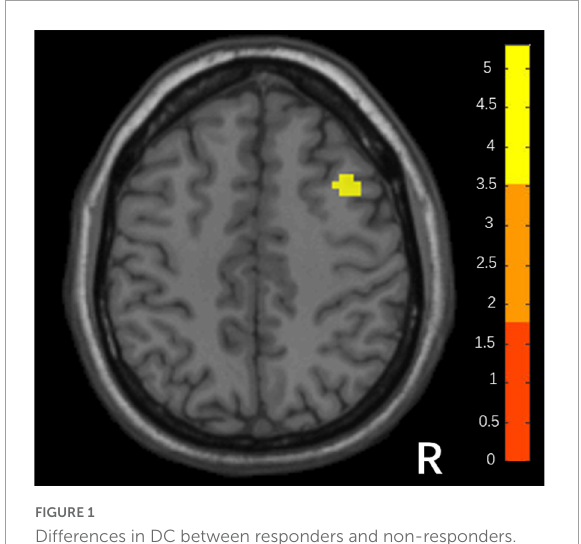
Differences in zFC values among responders, non-responders and HCs. (one-way ANOVA, Bonferroni’s Multiple Comparison Test. * p < 0.05, *** p < 0.0001).